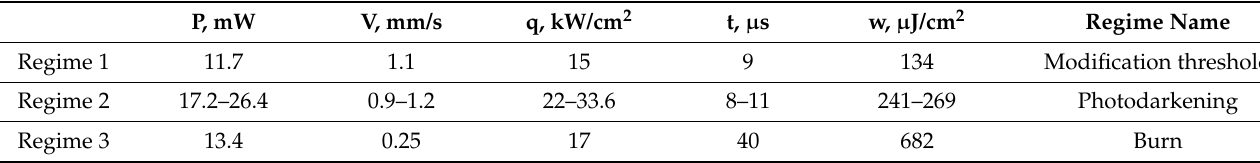
Table 2. Scanning modes with continuous UV radiation.